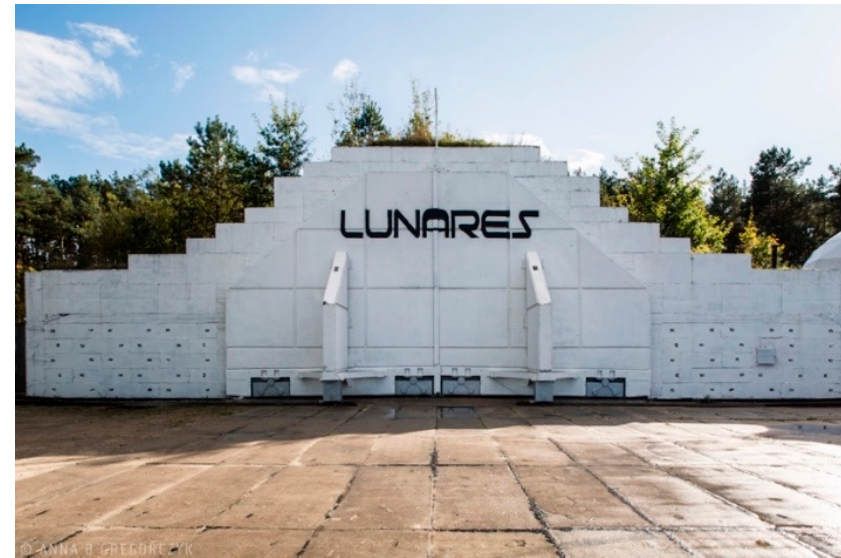
Figure 1. LunAres Research Station—Analog space base (Piła, Poland).